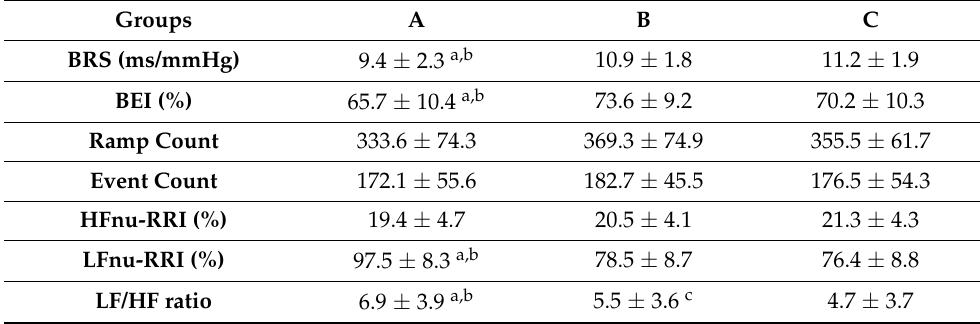
Table 3. Results of the Baroreflex sensitivity and HRV assessments (mean ± S.D.).